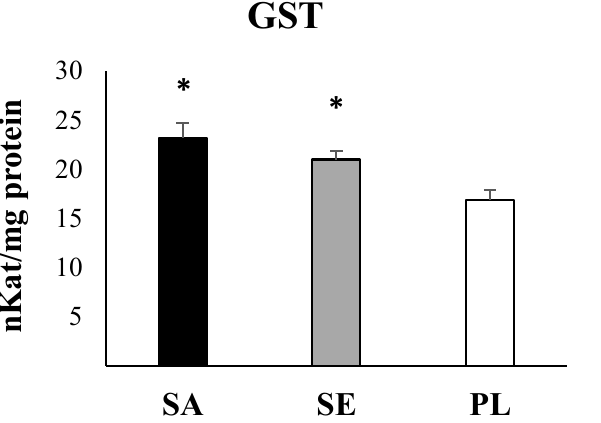
Figure 3. Activities of antioxidant enzymes in the digestive tract of H. tubulosa : ( A ) catalase (CAT); ( B ) superoxide dismutase (SOD); ( C ) glutathione reductase (GRd). Significant differences ( p -value < 0.05) are shown: * indicates differences respect to PL. SA, Sant Antoni de Portmany; SE, Santa Eulària des Riu; PL, Pou des Lleó.